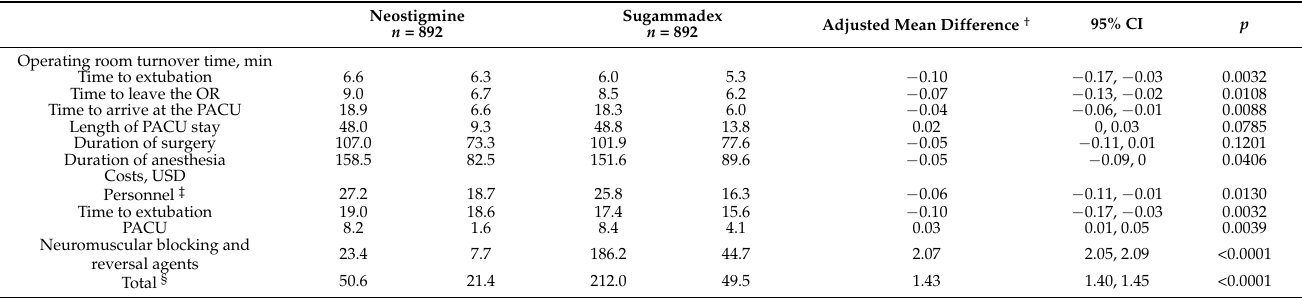
Table 3. Operating room turnover time and cost-effective analyses of the sugammadex and neostig- mine groups (matched cohort).